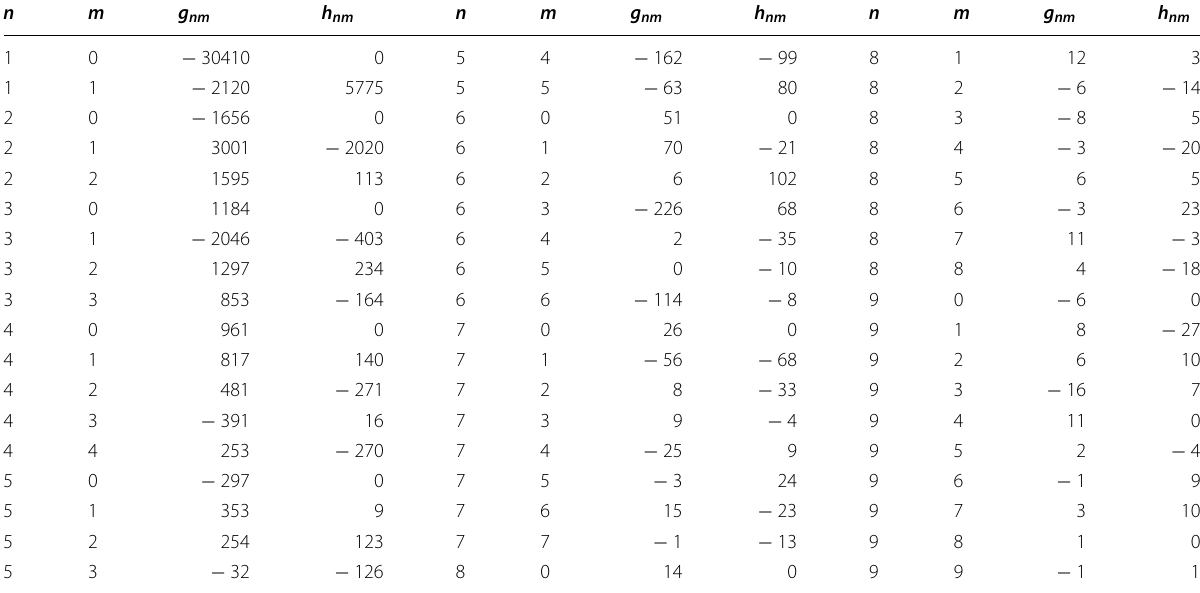
Table 2 Gauss coefficients of the new geomagnetic field model based on the measurements from the Kosmos-49 satellite (N-1); the coefficients are listed in three columns